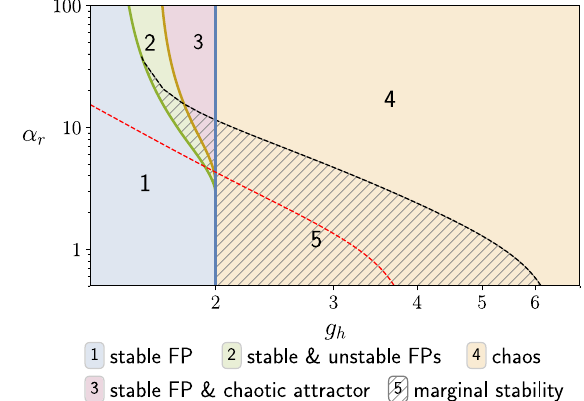
FIG. 7. Phase diagram for the gated RNN. (a) (no biases) In regions 1 and 2, the zero FP is the global attractor of dynamics; however, in region 2, there is a proliferation of unstable FPs without any asymptotic dynamical signatures. In region 3, the (stable) zero FP coexists with chaotic dynamics. Note that the 0 plotted curve separating regions 2 and 3 is computed for α z ¼ and remains valid for sufficiently small values of α . In region 4, z the zero FP is unstable, and dynamics are chaotic. For all parameter values in region 5, a previously unstable or chaotic ∞ . For any given state can be made marginally stable when α z ¼ parameter values in region 5, there are infinitely many marginally stable points in the phase space to which the dynamics converge. The red dashed line indicates the critical transition between a stable fixed point (below the line) and chaos (above the line) in the presence of static random input (to the h variable) with 0 . 5 . Note that, while chaos is suppressed standard deviation σ h ¼ for small α along the g axis, for larger α there are regions of r h r stable FPs that become chaotic with finite input. This leads to the phenomenon of input-induced